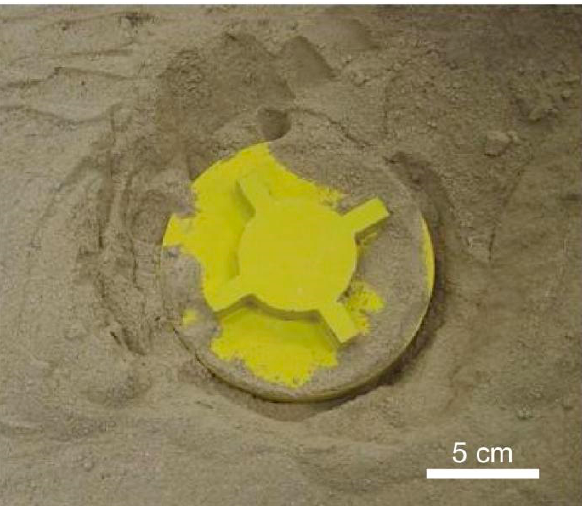
Figure 1. PMN-2 anti-person landmine.